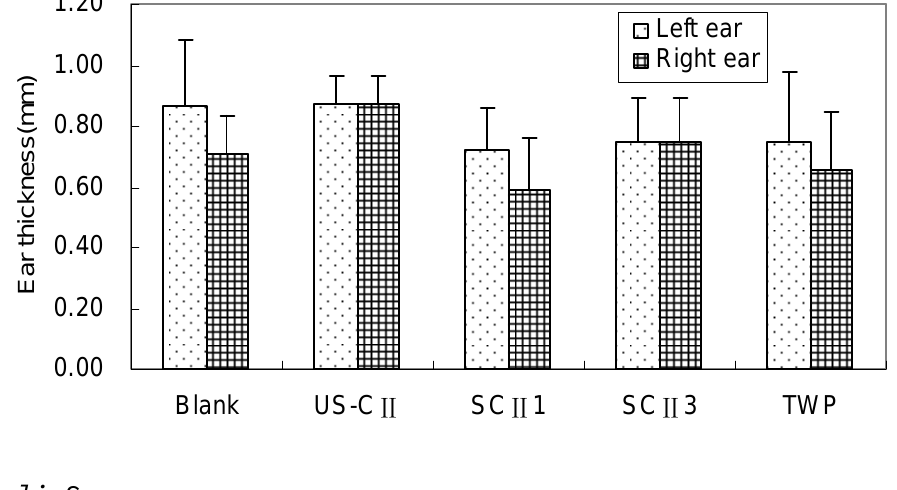
Figure 3. Effect of CII on DTH response in rats after immunization with CII and TWP: SCII was injected into the left ear intradermally on Day 7 and ear thickness measured 48 h later. The difference thickness between left and right ear in blank group, US-CII group, SCII 1 group and SCII 3 group, TWP group were 0.16 mm, 0.00 mm, 0.13 mm, 0.00 mm, and 0.10 mm, respectively.